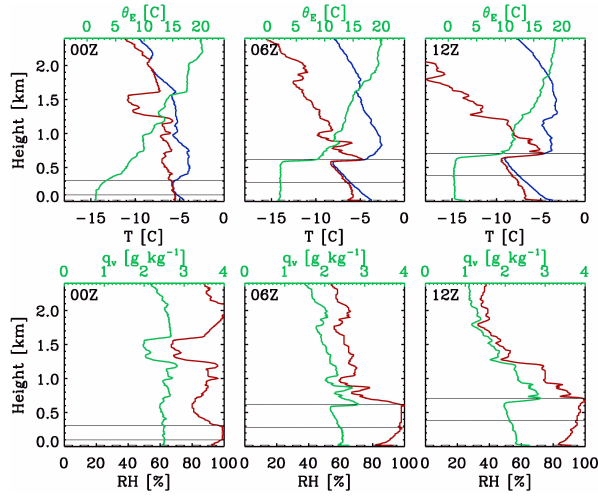
Fig. 10. As in Fig. 4, but for 0Z (left), 6Z (middle), and 12Z (right) soundings on 25 August 2008 (Case